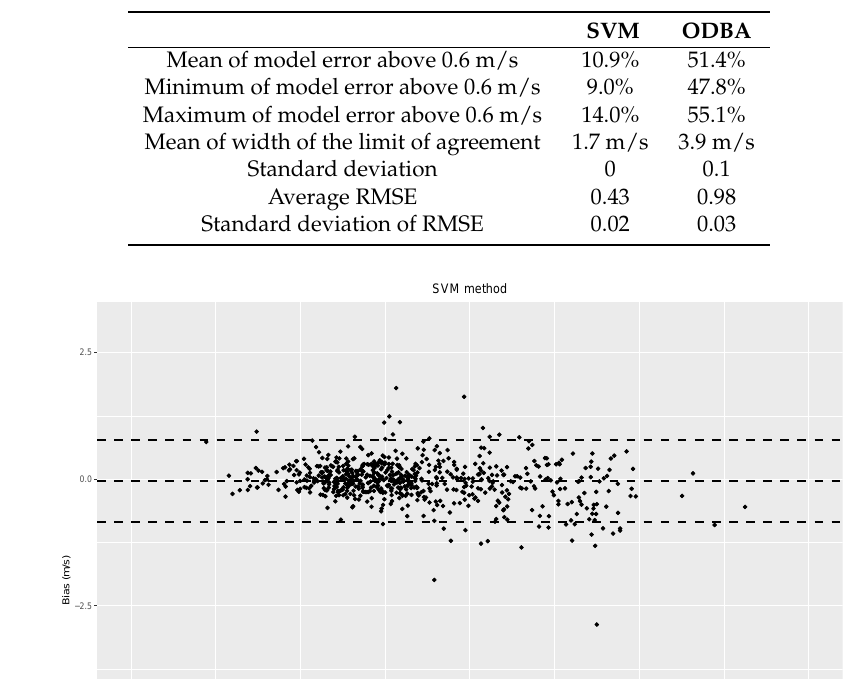
Table 1. Mean, minimum, and maximum of the percentage of error above 0.6 m/s and the mean (standard deviation) of the width of the Bland and Altman limit of agreement for 50 repetitions for each method.